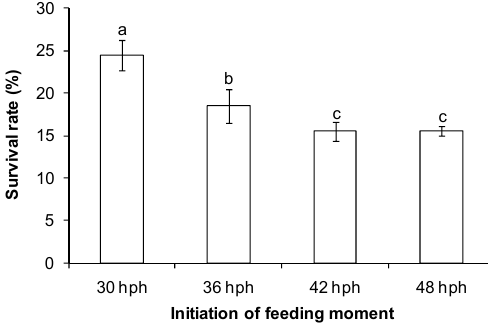
Figure 1. Survival rates of P. hypophthalmus larvae following 10 days of rearing under four initiation of feeding moments: 30 h post hatching (hph), 36 hph, 42 hph, and 48 hph. Each bar represents the mean value and standard deviation data for each feeding time treatment. Data with different letters are significantly different ( p < 0.05).